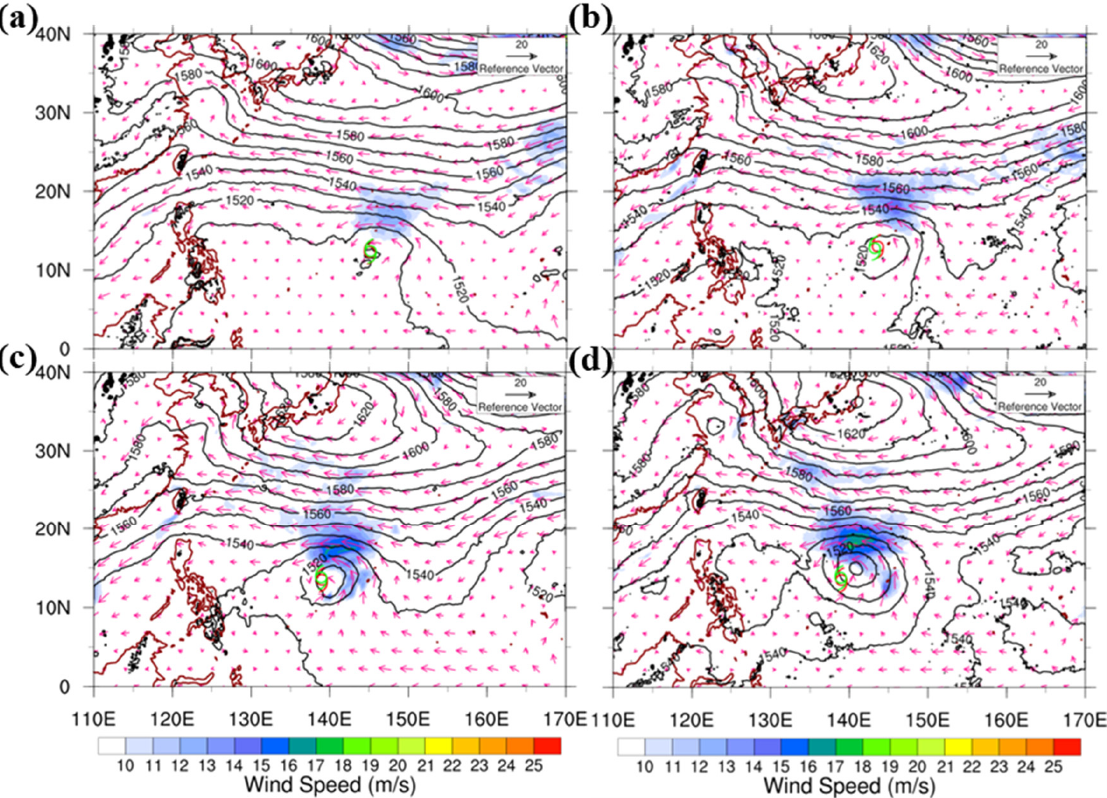
Figure 18. Geopotential height (contours at an interval of 10 gpm), wind speed (shaded in m s − 1 ), and wind vectors (m s − 1 ) at 850 hPa at 1200 UTC 26 September 2019 for ( a ) the NCEP FNL data and ( b ) after the first DA cycle. ( c , d ) as in ( a , b ), respectively, but at 0000 UTC 27 September 2019. The initial center position of Typhoon Mitag from the best track data of CWB and JTWC is indicated by the red typhoon sign and green typhoon sign, respectively.